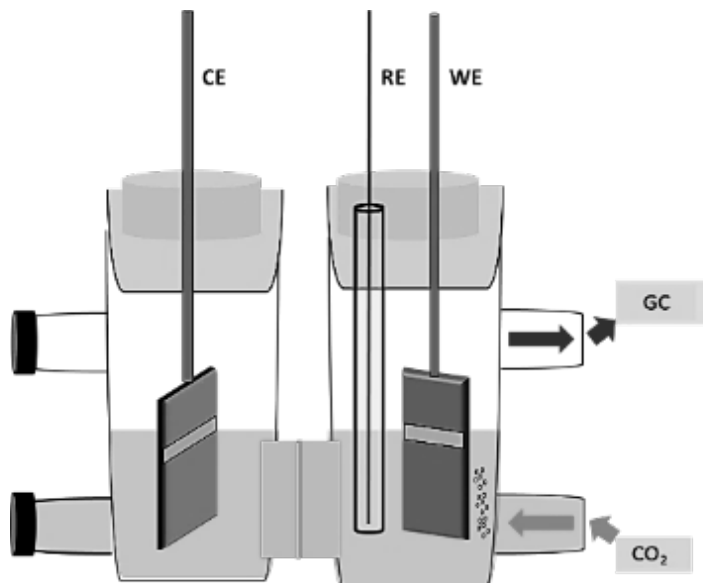
Figure 1. Schematic of a 3-electrode H-cell setup for the CO 2 reduction reaction (CO 2 RR) test. In addition to the porous Cu samples, Cu foils were also tested in the CO 2 RR process for a comparison purpose. The surface of the Cu foil samples was polished by 400 grit silicon carbide paper prior to the